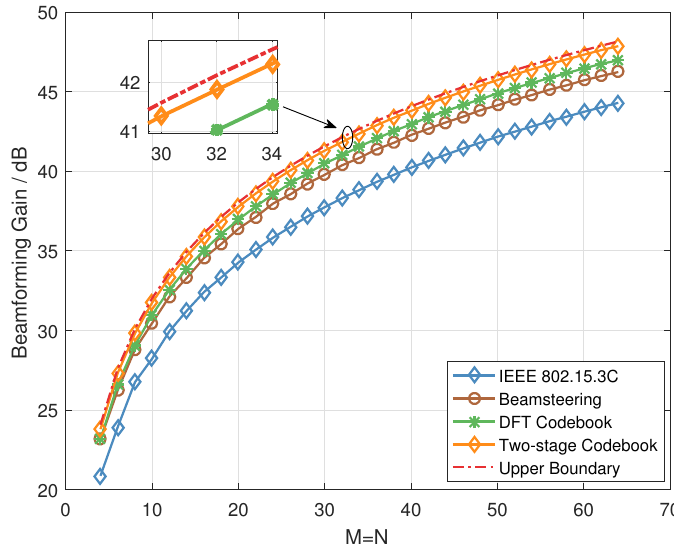
Figure 7. The Beamforming gains of the various